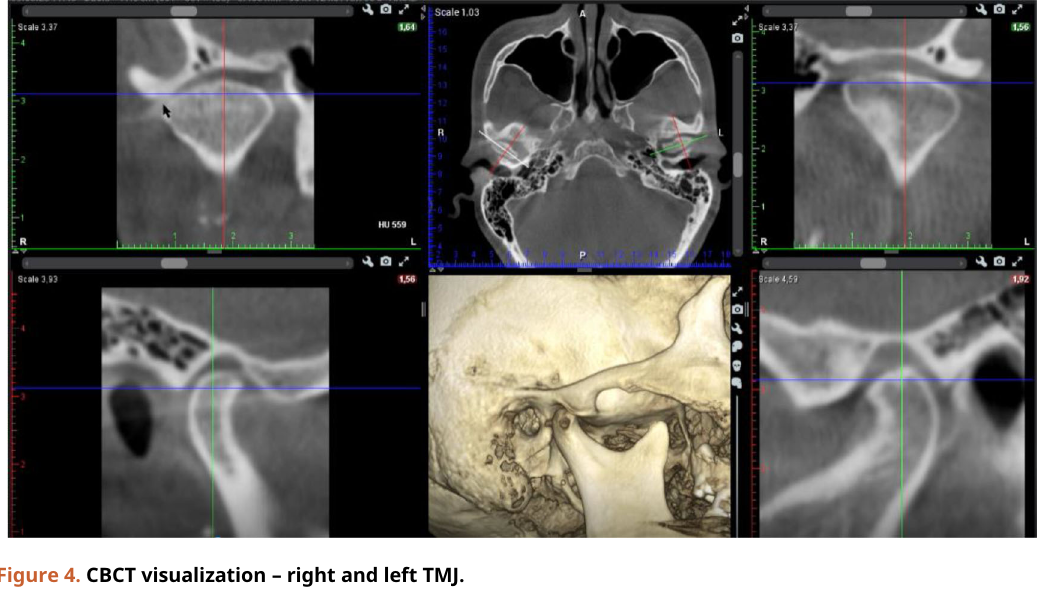
Figure 4. CBCT visualization – right and left TMJ.